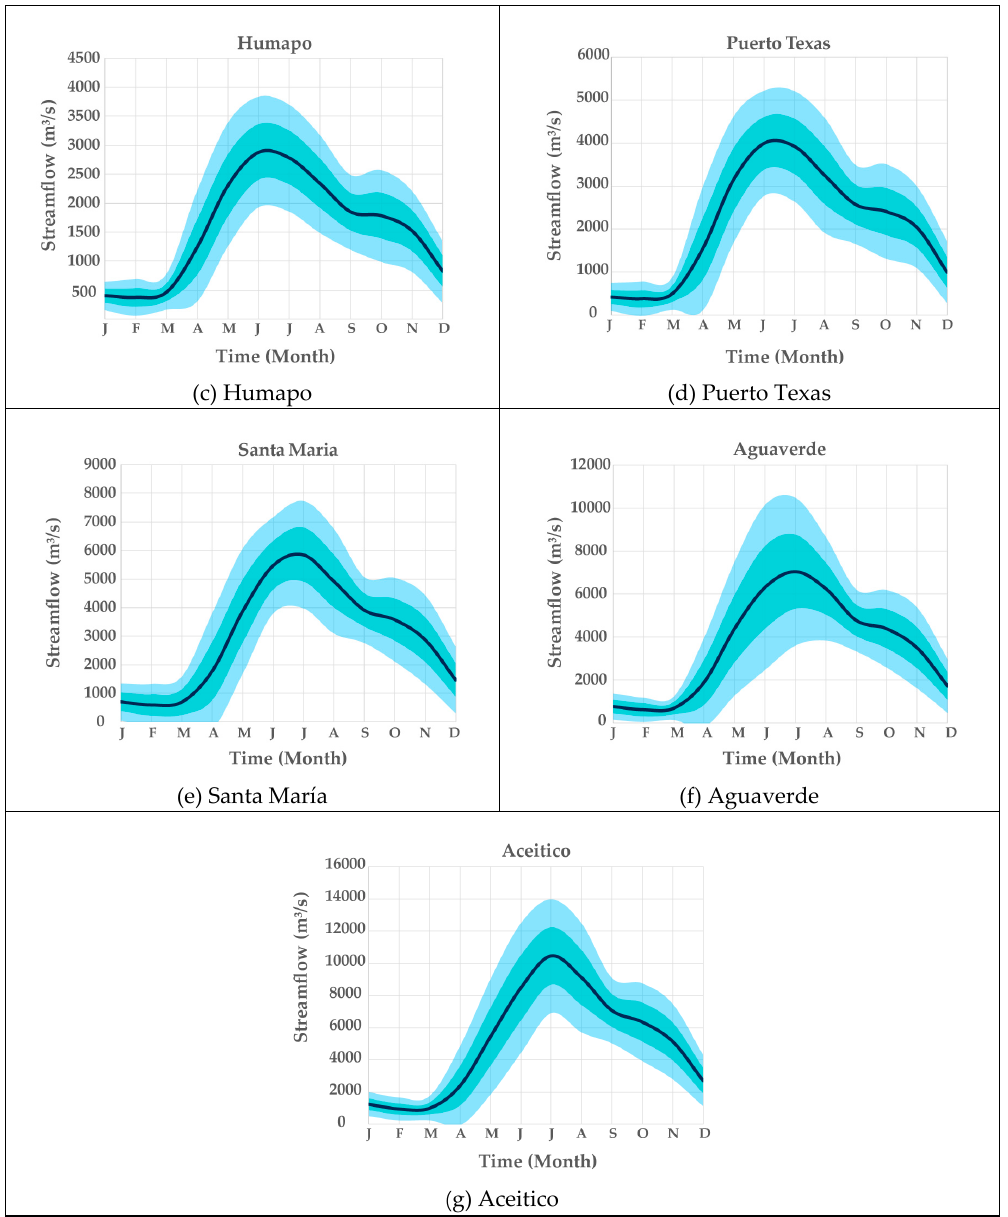
Figure 3. Average streamflow hydrographs for the seven gauging stations of the study.